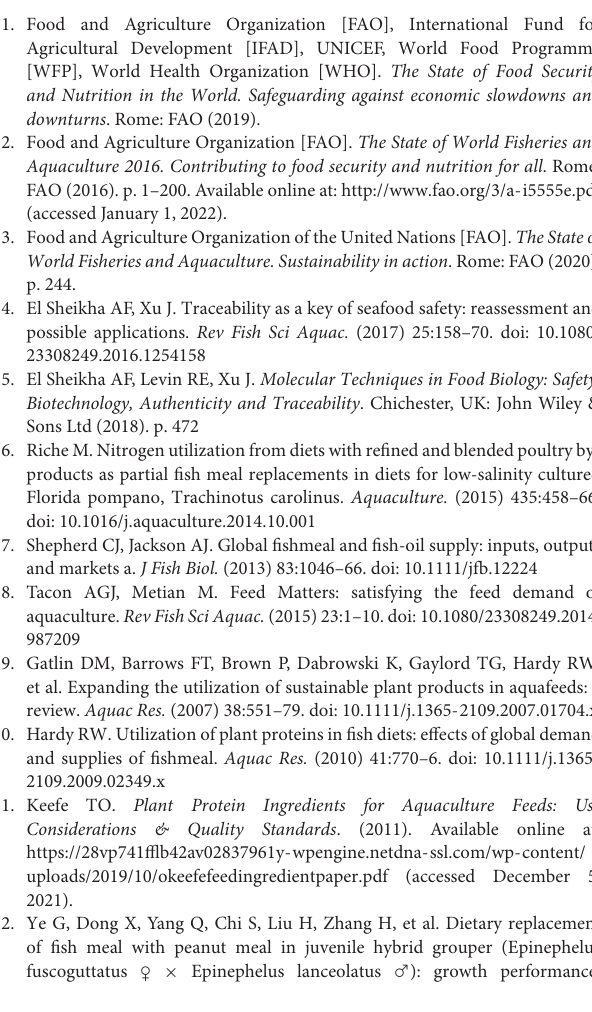
Supplementary Figure 1 | The individual sample repeats representative UPLC-MC spectra of the distal intestine in the (A) positive, and (B) negative modes. FM-1 to FM-6 represent the individual sample repeats of FM; CM4-1 to CM4-6 represent the individual sample repeats of CM4; CM20-1 to CM20-6 represent the individual sample repeats of CM20 FM, fish meal (control group); CM4, 4% Castor meal (CM) protein replacement to FM protein; CM20, 20% CM protein replacement to FM protein. Supplementary Figure 2 | The results of the total PLS-DA score plots from the UPLC-MS spectra of the distal intestinal contents in positive (A) and negative (B) modes. A1 and A2 are, respectively the positive modes between FM and CM4, and FM and CM20 groups; B1 and B2 are respectively the negative modes between FM and CM4, and FM and CM20 groups. N = 6. Supplementary Figure 3 | The detailed clustering heatmap of total differential metabolites in the positive (A) and negative (B) modes after fishmeal replacement with castor meal. Individual groups are clustered in the vertical part, whereas those of the metabolites are clustered in the horizontal part. Colour intensity indicates the intensity of the metabolite. The relationship of metabolite content clustering between groups can be seen horizontally. The shorter the cluster branch is, the higher the similarity is. FM, fish meal (control group); CM4, 4% castor meal (CM) protein replacement to FM protein; CM20, 20% CM protein replacement to FM